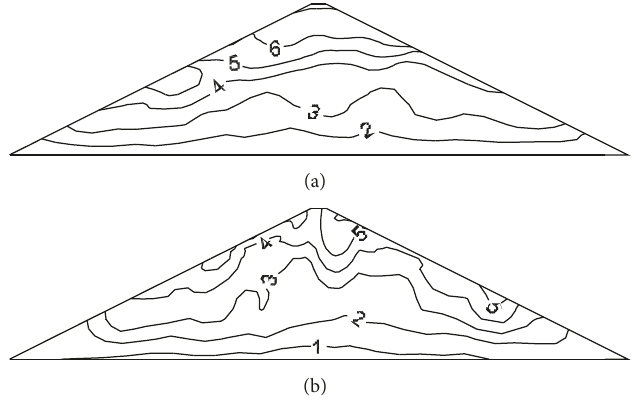
Figure 19: Acceleration distribution for Scheme 3 (unit: m/s 2 ): (a) horizontal and (b)